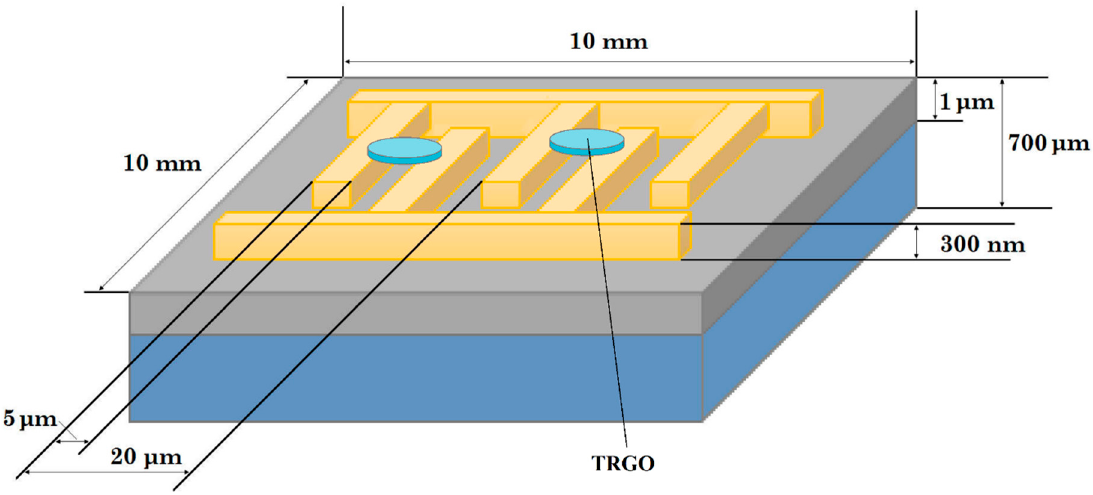
Figure 1. A simplified structure drawing.